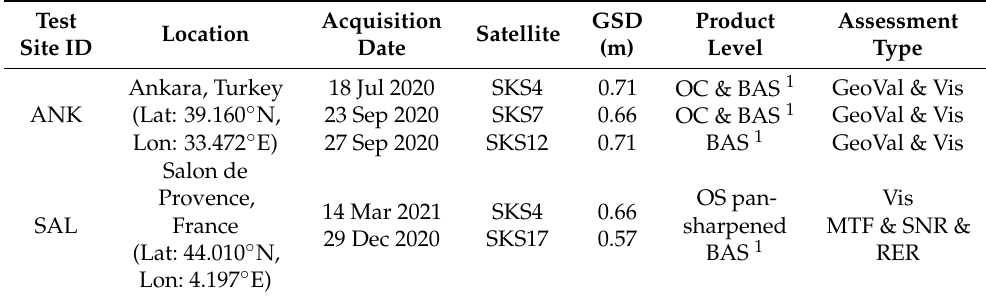
Table 2. The main features of the SkySat data used in the